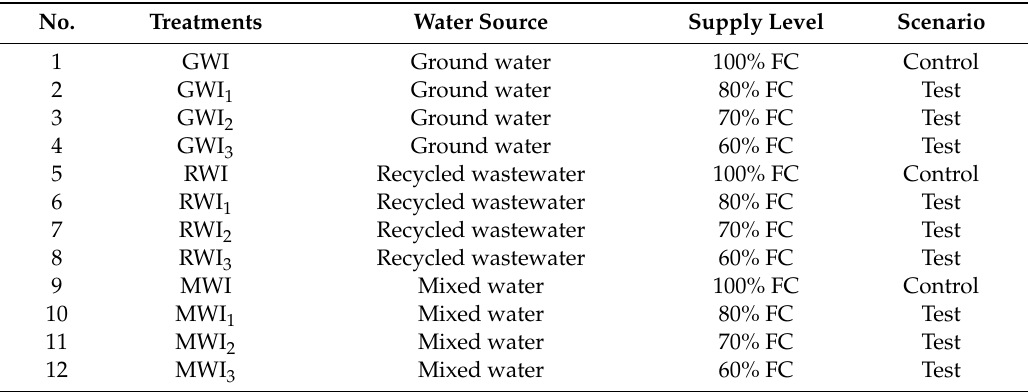
Table 2. Details of the experimental design